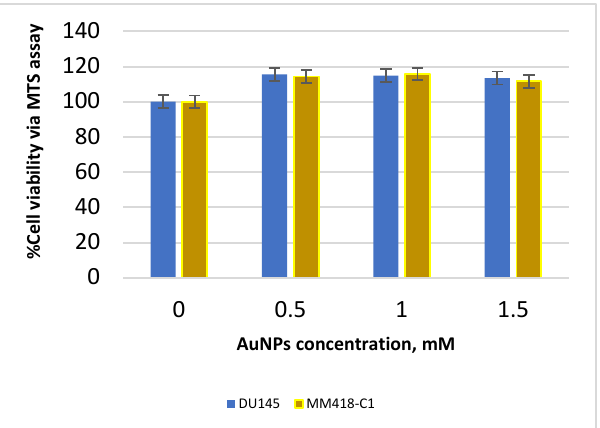
Figure 2. Cell viability (MTS assay) for DU145 cell line 24, 48, and 72 h after being treated with various concentrations of AuNPs. Data are represented as mean values ± SD of three replicate samples.